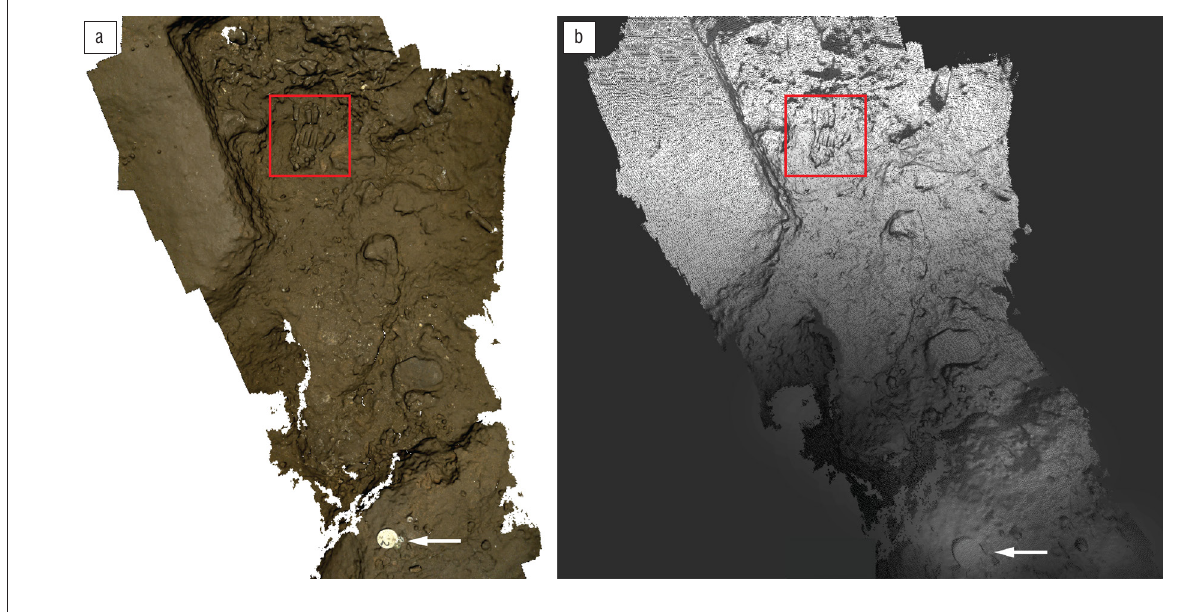
Figure 7: (a) In-situ white-light source photogrammetry mesh of the area surrounding adult ‘Hand 1’ of Homo naledi indicating a reference pin marker (designated with an arrow); and (b) the same mesh converted to the .e57 point cloud data structure, indicating the same pin marker.